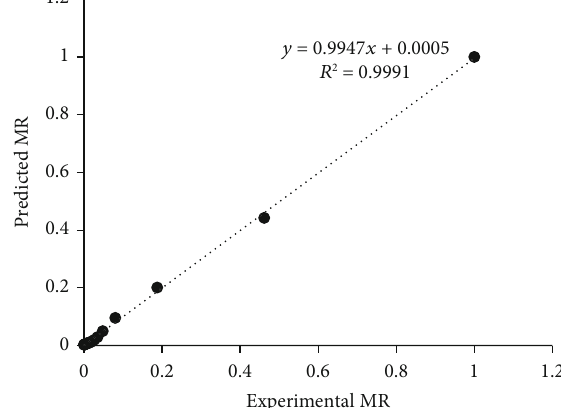
Figure 5: Comparison of predicted moisture ratio (MR) by Verma et al. model with observed MR for oven drying.